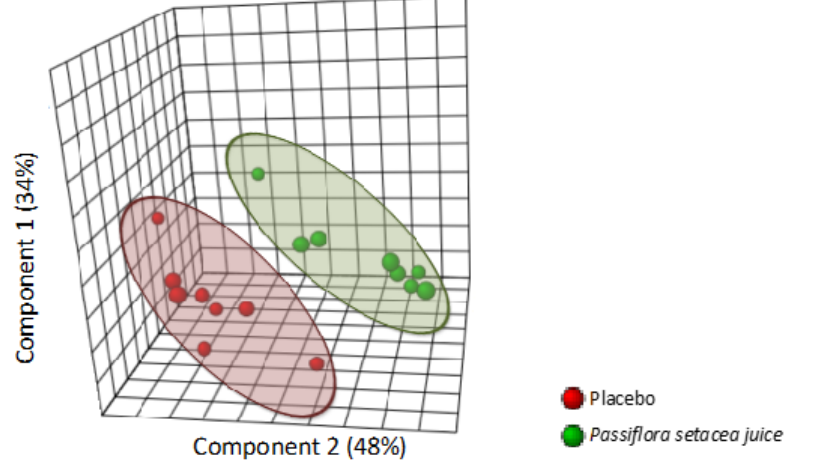
Figure 3. The comparison of the global gene expression profiles obtained for the volunteers using partial least squares discriminant analysis (PLSDA) shows the separation of profiles between the two groups, and suggests di ff erent gene expression profiles between the volunteers that consumed Passiflora setacea juice (PF) and the volunteers that consumed placebo (PB;